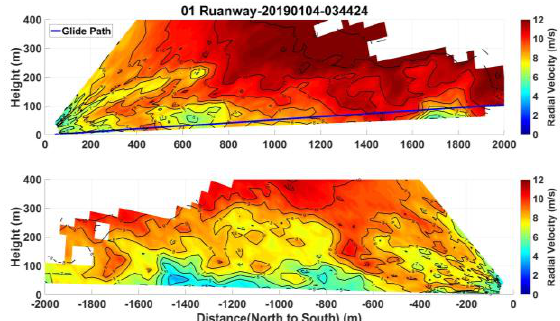
Fig.8. Radial velocity from RHI scanning around the 01/19